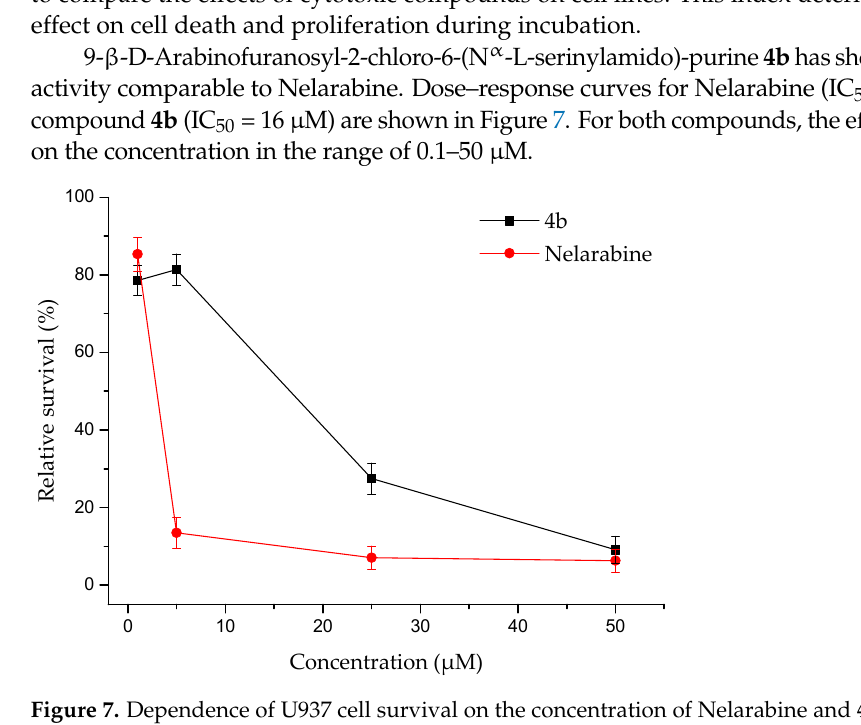
Table 5. Inhibition of E. coli adenosine deaminase.